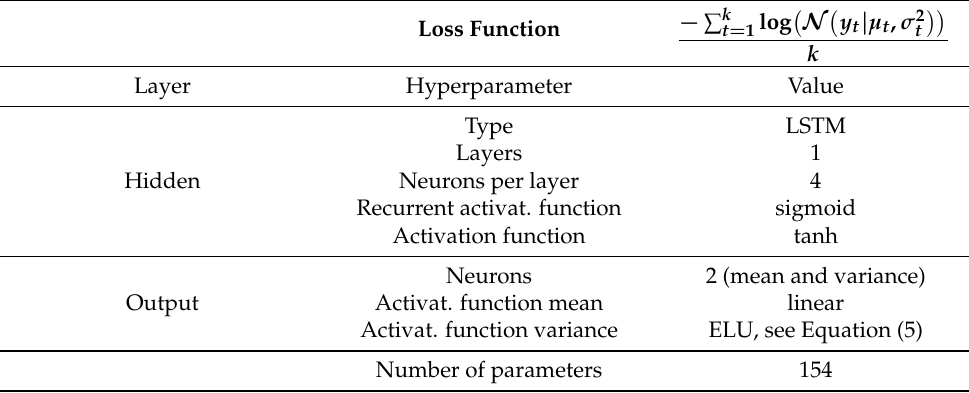
Table 2. Meijner’s architecture hyperparameters [7].